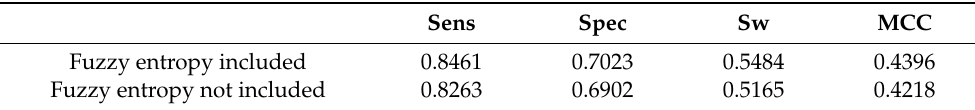
Table 9. Influence of fuzzy entropy on SVM-FE prediction results.